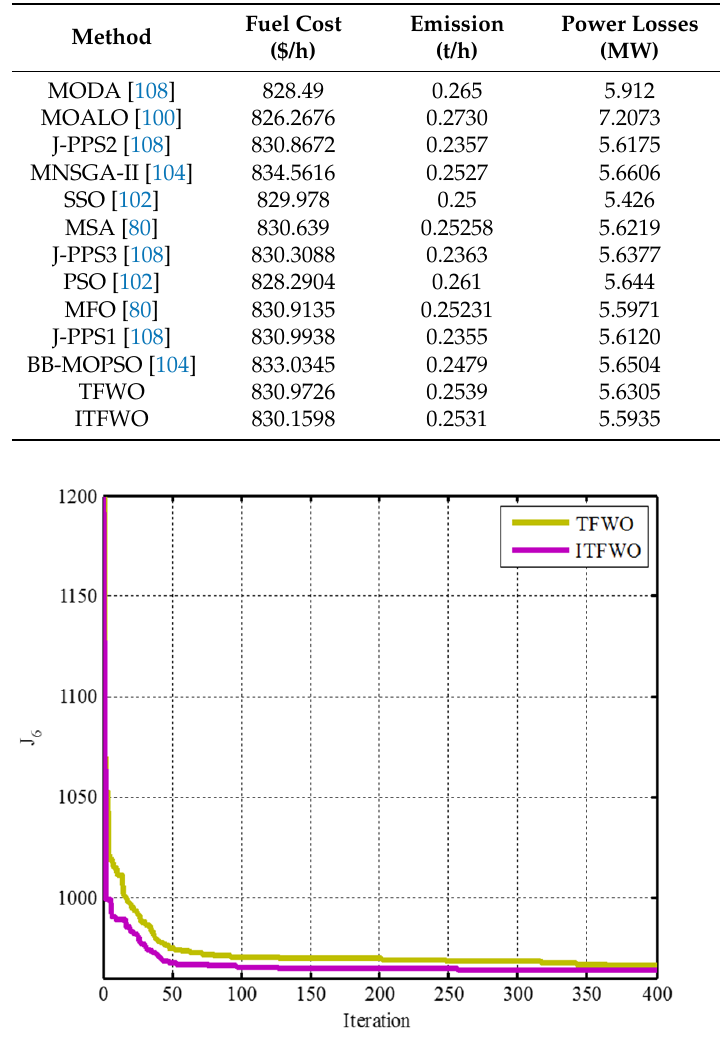
Figure 8. Optimization process for Type 6.